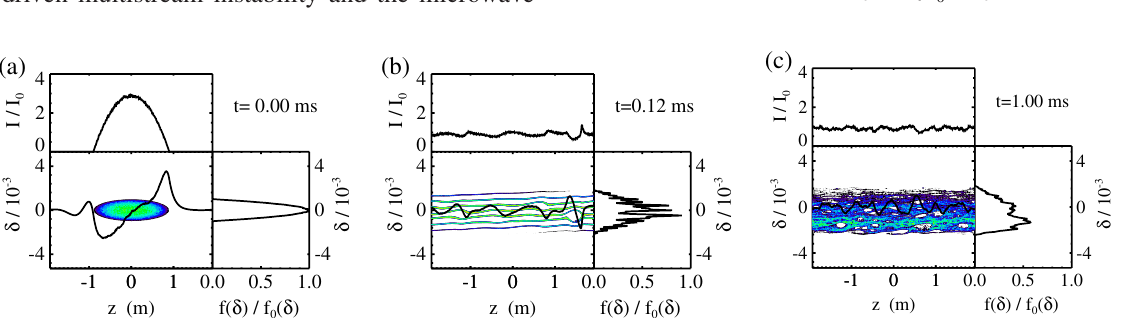
FIG. 10. Snapshots of the simulated time evolution of multistream instability and the effect of a broadband resonator impedance. In (a), the deformation of the initial electric field caused by the impedance is clearly visible. Still one can observe the onset of the multistream instability between the inner filaments (b) and a subsequent broad fluctuation spectrum after 1 ms